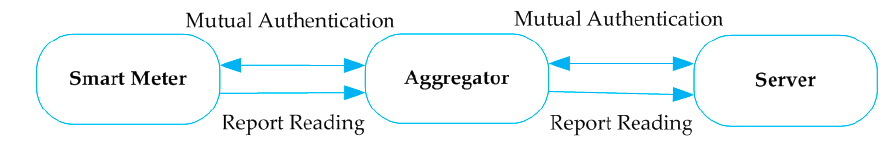
Figure 2. The abstract structure of the model.